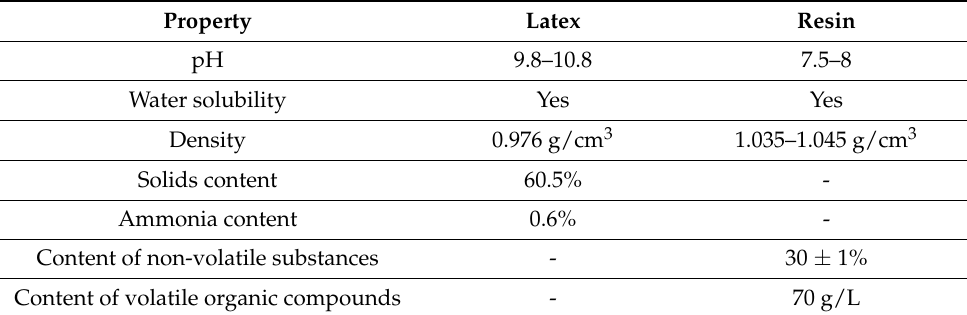
Table 1. The characteristics of the resin and latex, according to the